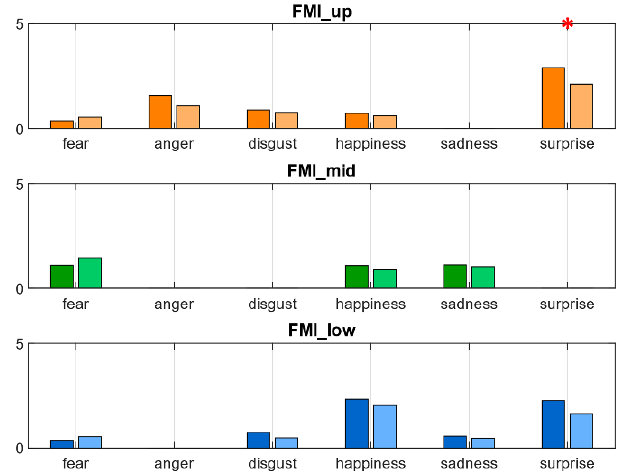
Figure A1. FMI computed on statistically significant different distances.